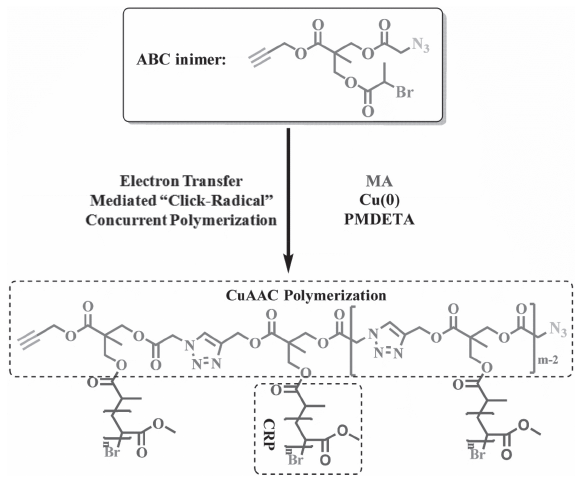
Figure 9. One-step synthesis of brush polymer from small molecules by concurrent ATRP and copper-catalyzed azide-alkyne cycloaddition (CuAAC) click polymerization. Adapted with permission from [65], Copyright© 2017 WILEY-VCH Verlag GmbH & Co. KGaA, Weinheim.